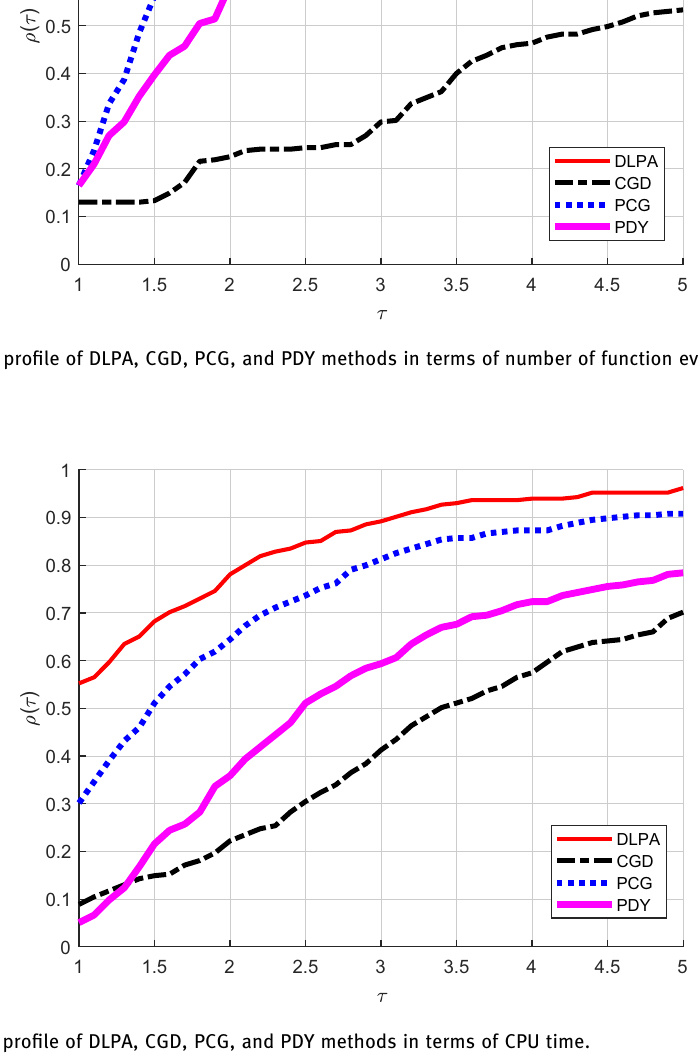
Figure 3: Performance pro fi le of DLPA, CGD, PCG, and PDY methods in terms of CPU